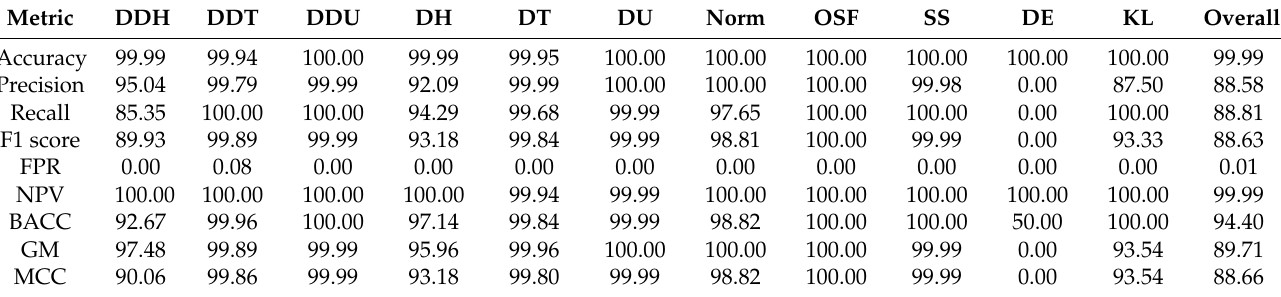
Figure 6. Cross-entropy losses during validation. Table 4. Classification performance of DRNN